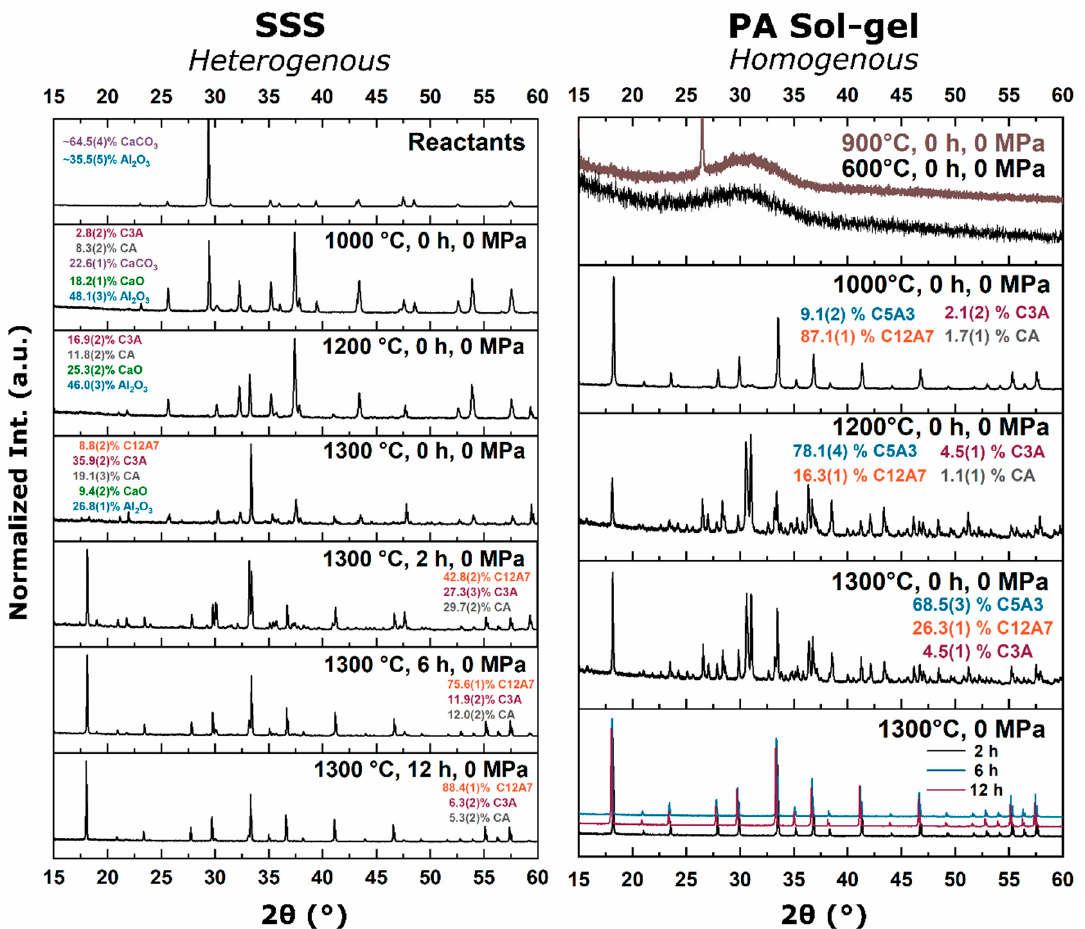
Figure 11. ( Left ) Kinetic phase evolution behavior of the heterogenous SSS reactants with processing temperatures of 1000, 1200, and 1300 °C and a 0 h processing time, and for processing times of 2, 6, and 12 h for samples with a processing temperature of 1300 °C. ( Right ) Kinetic phase evolution of calcined homogenous polymer assisted sol-gel reactants with processing temperatures of 600, 900, 1000, 1200, and 1300 °C and a processing time of 0 h, and for processing times of 2, 6, and 12 h for samples with a processing temperature of 1300 °C.